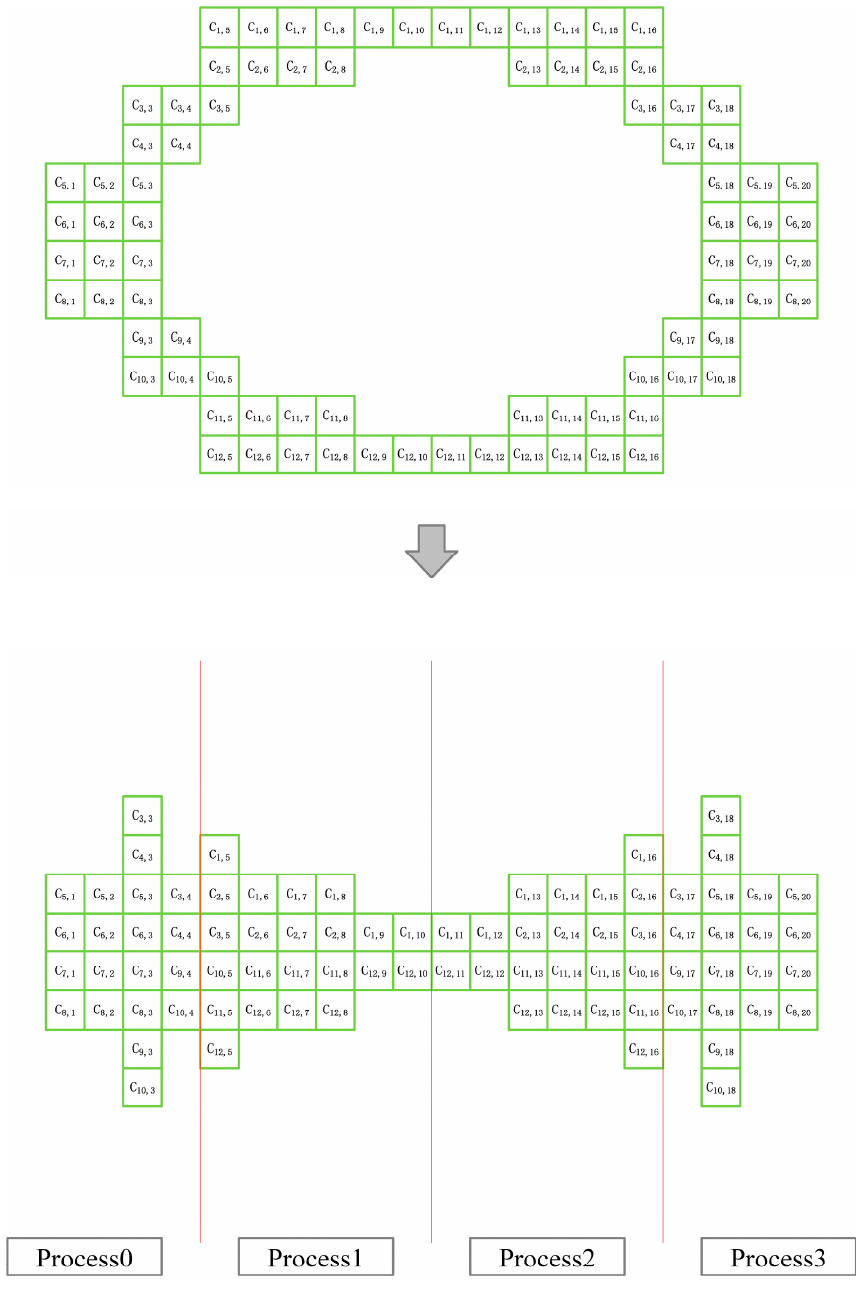
Figure 11. The 84 grid points in the third layer of the grid are divided into one dimension, and the number of grid points allocated to the 4 MPI processes are 20, 22, 22, and 20. According to the grid-division method described above, the grid from the first layer to the third layer is basically evenly divided into 4 equal parts. Each MPI process can be responsible for a part of each layer of the grid. The algorithm defines the process numbers of the four MPI processes as 0, 1, 2 and 3. Then, the computational grid responsible for a single process of these four MPI processes is shown in Figure